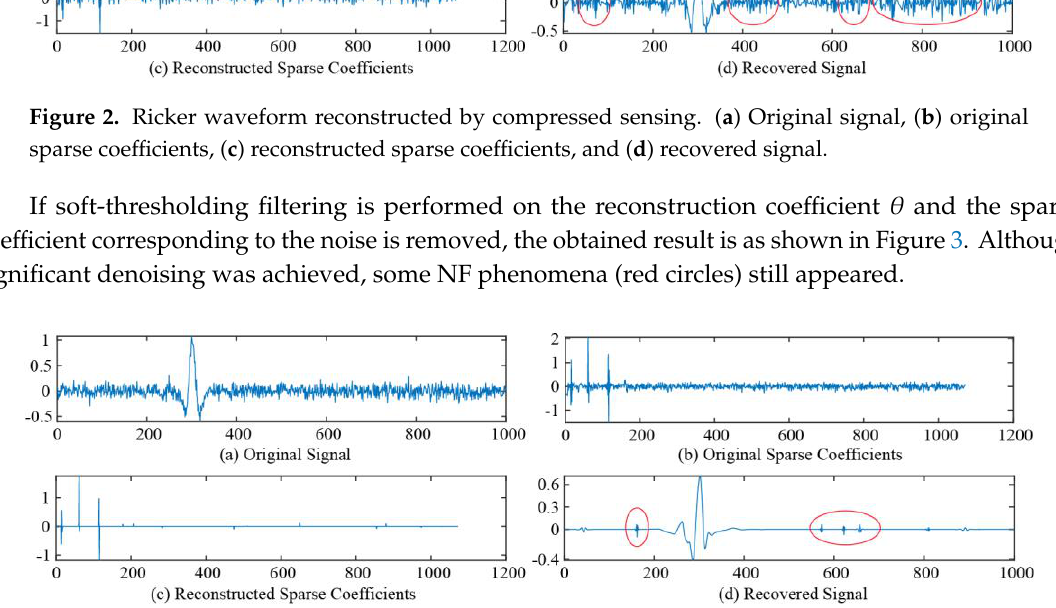
Figure 3. Ricker waveform after compressed sensing threshold denoising. ( a ) The original signal, ( b ) original sparse coefficients, ( c ) reconstructed sparse coefficients, and ( d ) recovered signal.